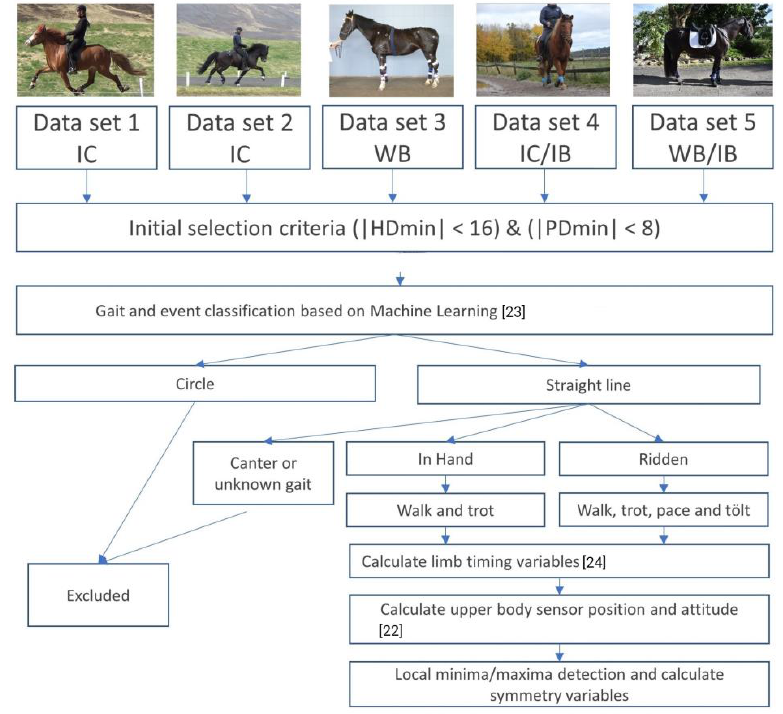
Figure 1. Schematic representation of the data-processing procedure applied for the different data sets. IC: Icelandic horse, WB: Warmblood horse, IB: Iberian horse. HDmin: difference in minimum position of the head between left and right diagonals at trot. PDmin: difference in minimum position of the pelvis between left and right diagonals at trot.